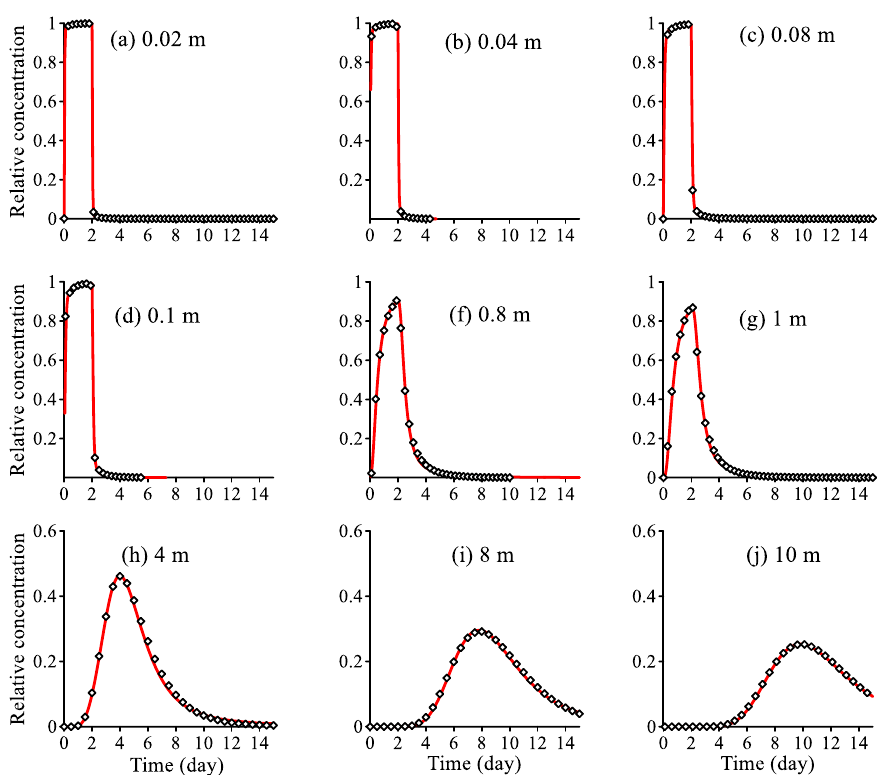
Figure 5. Fracture: The best-fit (lines, using the FADE (7)) versus the Monte Carlo BTCs (symbols) of dissolved pollutants moving at different travel distances along the saturated fracture-matrix medium plotted in Figure 4. Table 2. The best-fit parameters in the FADE (7a) for the snapshots shown in Figure 5. In the legend, “RMSE” denotes the root mean square error which evaluates the